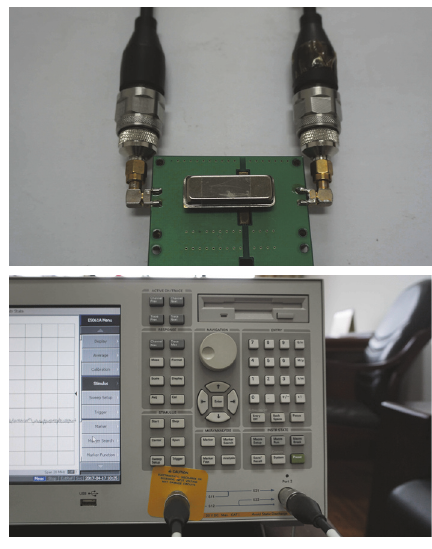
Figure 6: The connection of a sensor and the network analyzer.